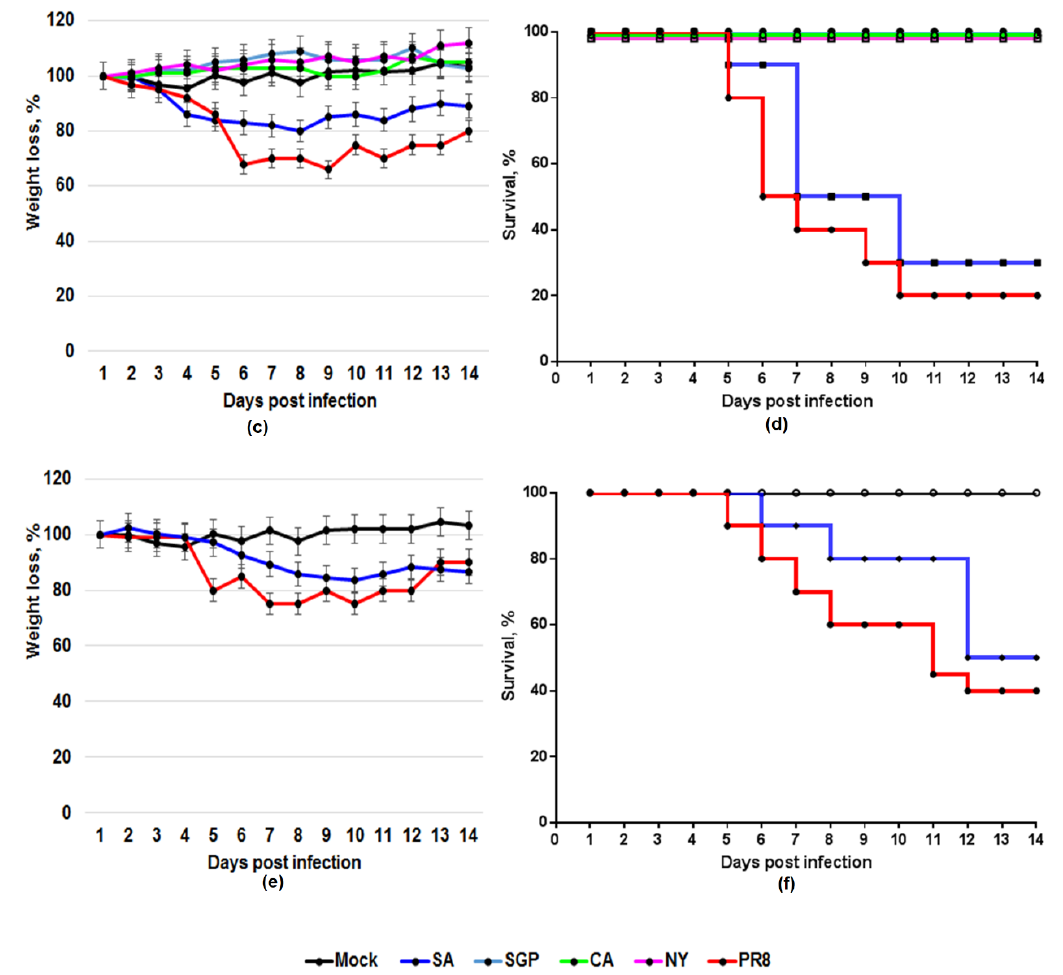
Figure 1. Weight loss and lethality of the influenza viruses for BALB/c mice. Weight loss, % ( a , c , e ), and survival, % ( b , d , f ), were monitored daily for 14 days. Mice were inoculated intranasally with 8.5 log 10 EID 50 ( a , b ), 7.5 log 10 EID 50 ( c , d ) or 5.0 log 10 EID 50 (1–10 LD 50 ) ( e , f ).